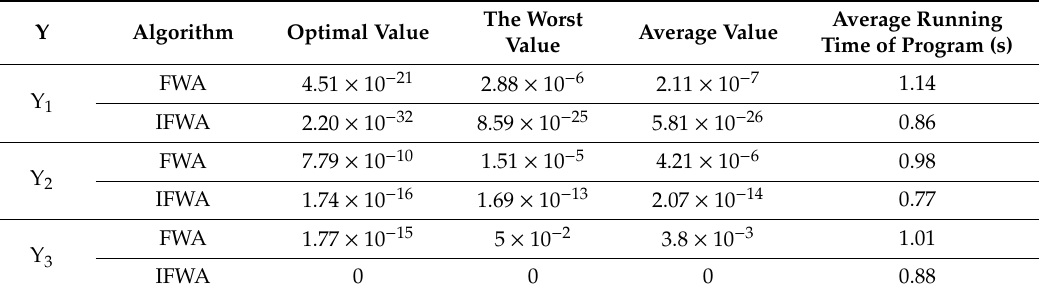
Table 7. Test results.